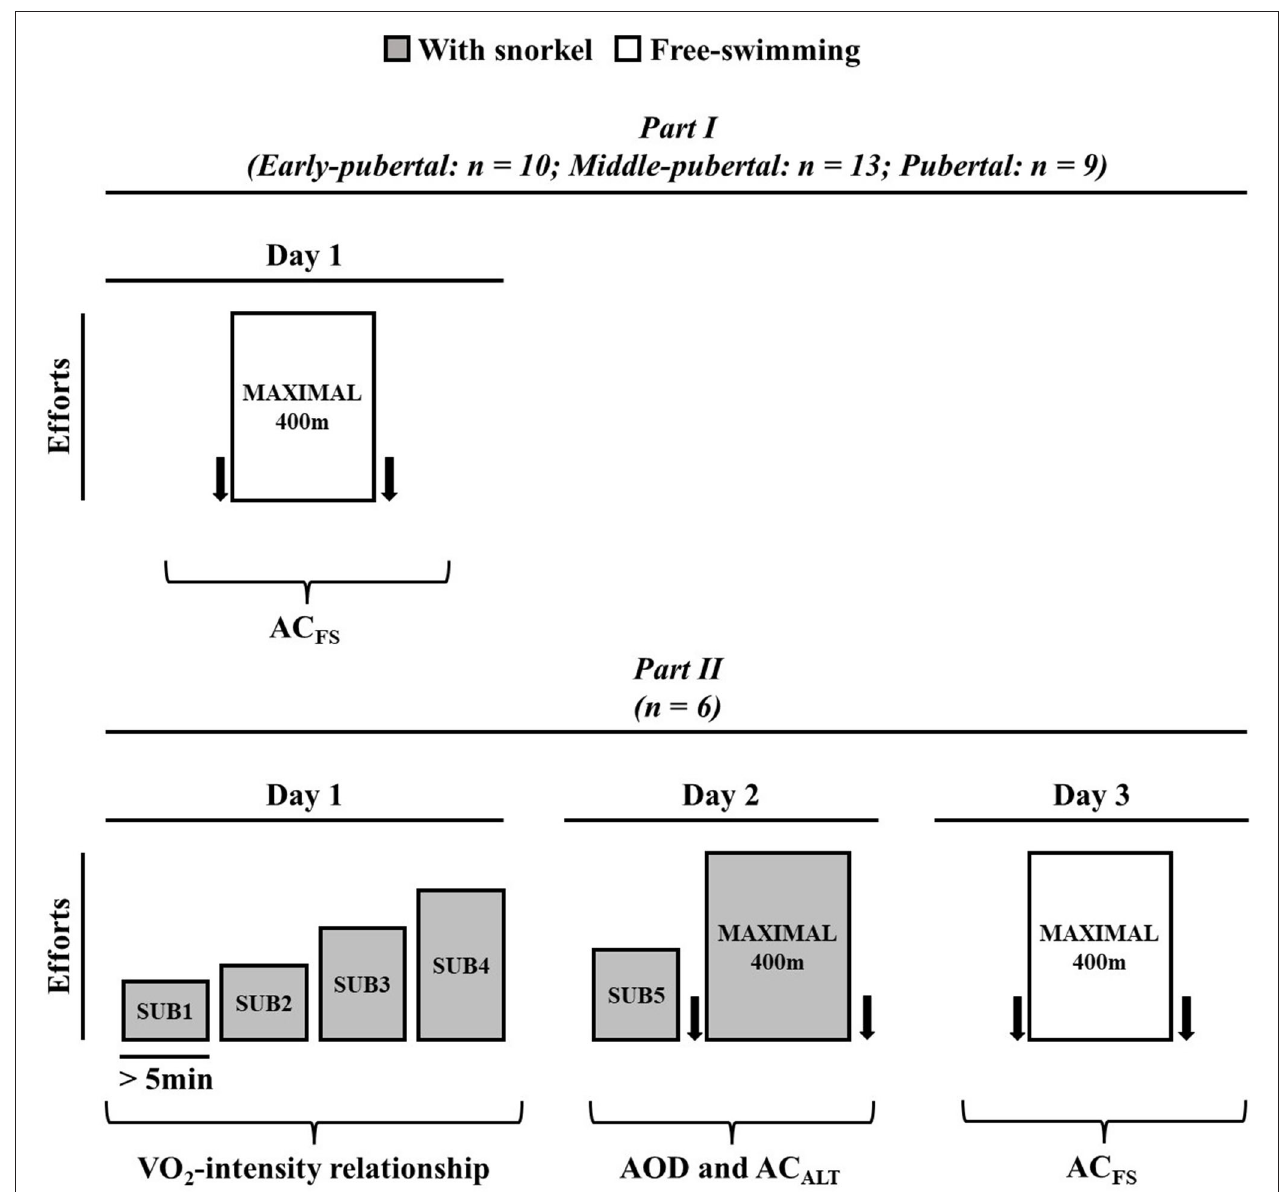
FIGURE 1 | Experimental design for Part I and Part II. Arrows represent blood sample to determine lactate concentration. recorded before the first submaximal exercise (observed on the first day; Reis et al., 2010b). This first maximal front crawl 400 m effort (second day trial) was used to evaluate AOD and AC ALT ( Figure 1 ) and the swimmers used snorkel during the effort. After at least 48 h, the swimmers were subjected to another 400 m maximal effort without snorkel (AC FS